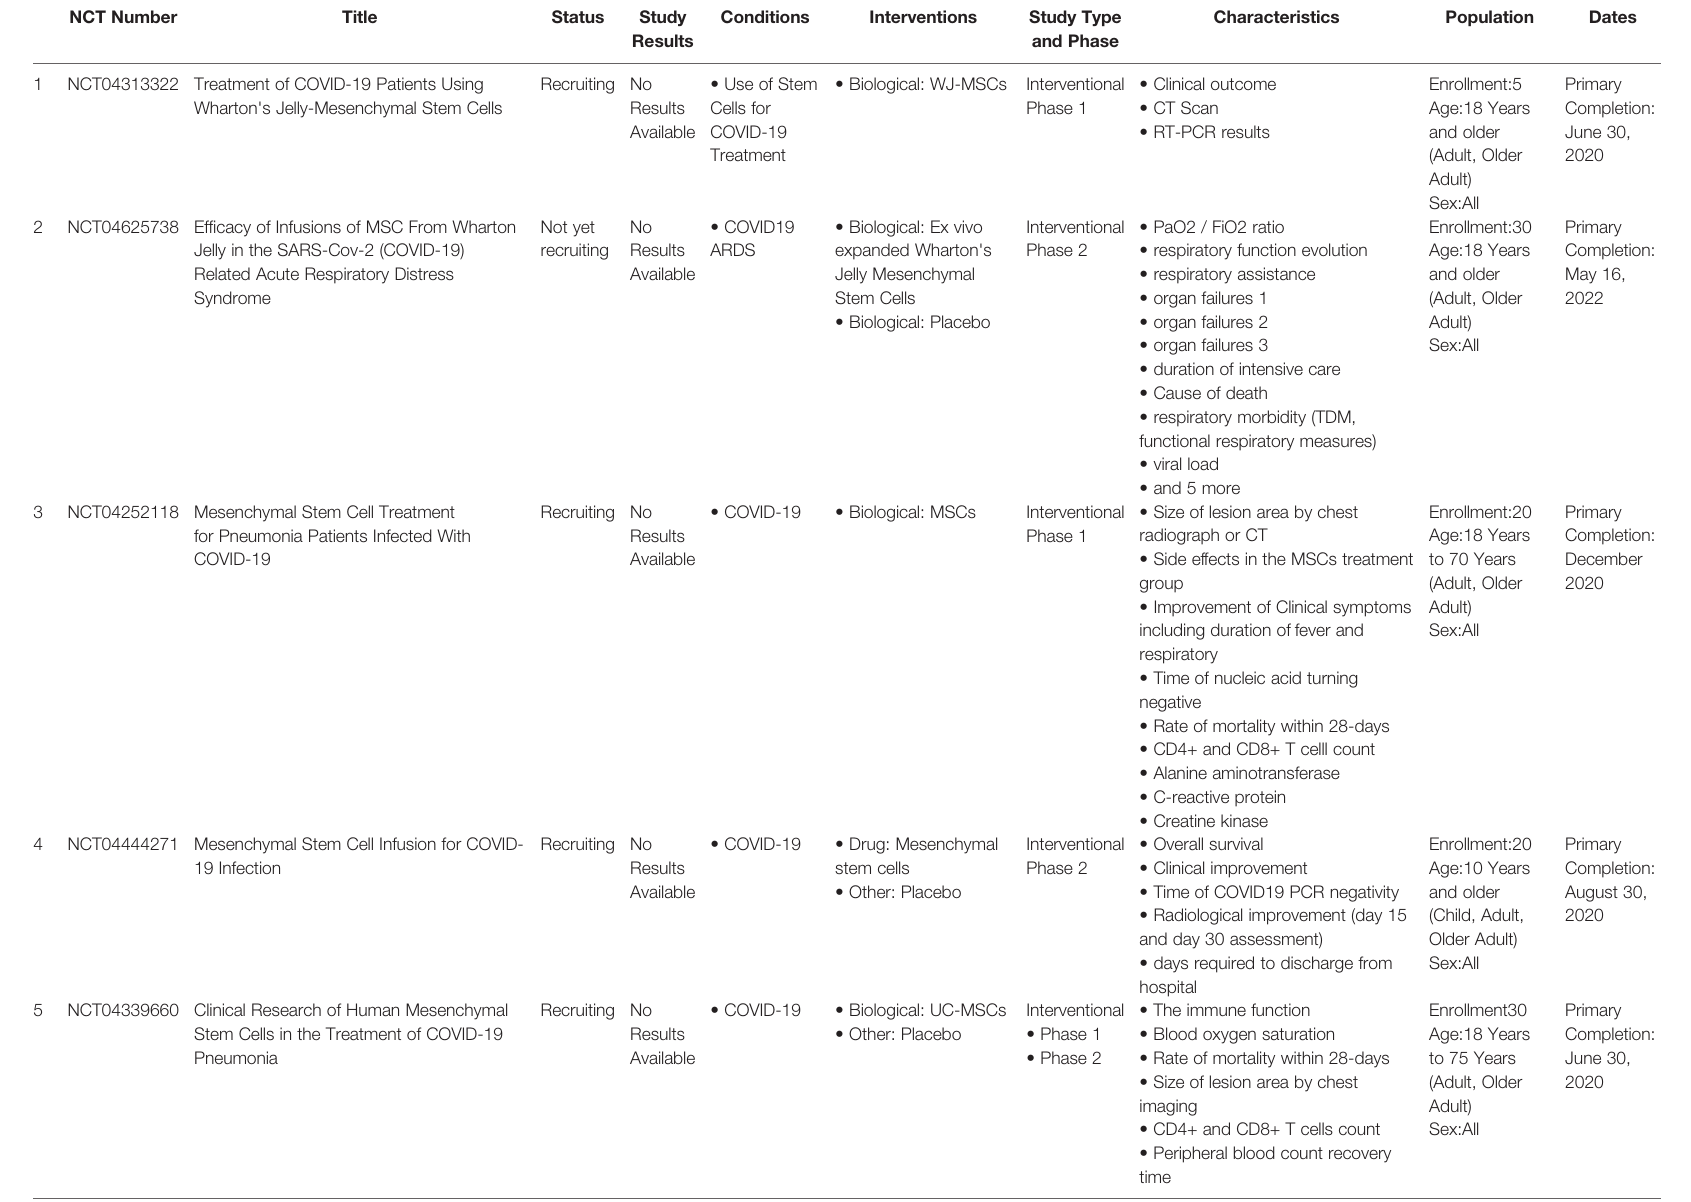
TABLE 2 | Selected Clinical Studies Examining Effects MSCs of Relevance to